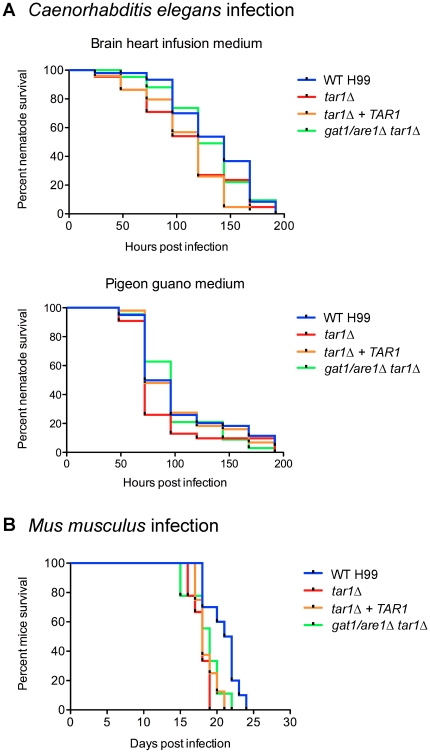
The tar1Δ mutant kills C. elegans as efficiently as wild-type, but exhibits modestly enhanced virulence in a murine host.(A) C. elegans infection: ∼50 nematode worms were transferred to a lawn of wild-type H99, tar1Δ, tar1Δ+TAR1 or double gat1/are1Δ tar1Δ cells as the sole food source on both BHI and 1% pigeon guano medium, and survival was monitored at 24 hr intervals. There was no observable difference in C. elegans killing by all four strains on both media. (B) Mus musculus infection: 10 mice were each intranasally infected with either 5×105 cells of wild-type H99, tar1Δ, tar1Δ+TAR1 or double gat1/are1Δ tar1Δ strains, and survival was monitored daily. Mice infected with the tar1Δ, tar1Δ+TAR1 and double gat1/are1Δ tar1Δ strains progress to morbidity slightly more rapidly than mice infected with the wild-type strain.